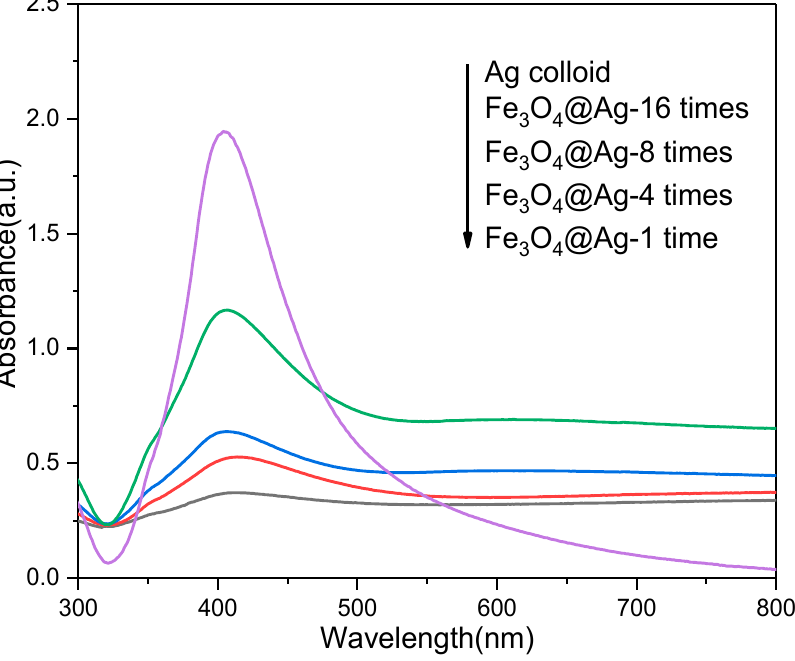
Figure 2. UV-vis absorption spectra of Ag colloid and AgMNPs prepared with different concentra- tions of Ag colloid.